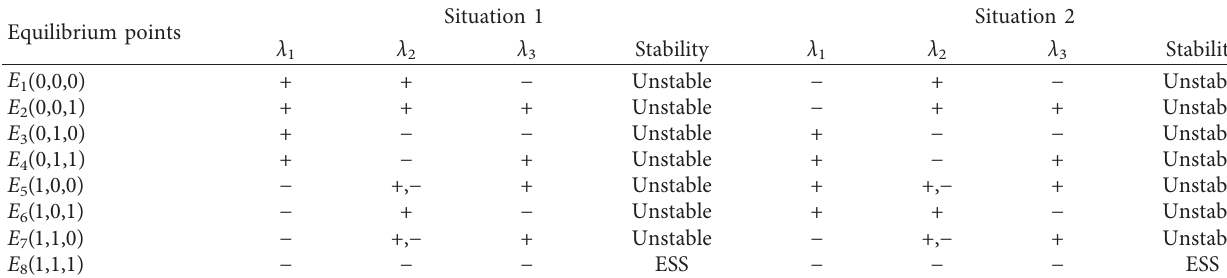
Table 4: Equilibrium points and